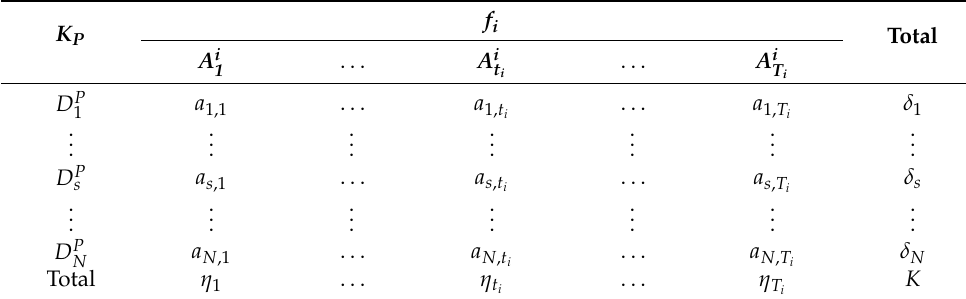
Table 1. The casting result of sample pairs ( f i , K P